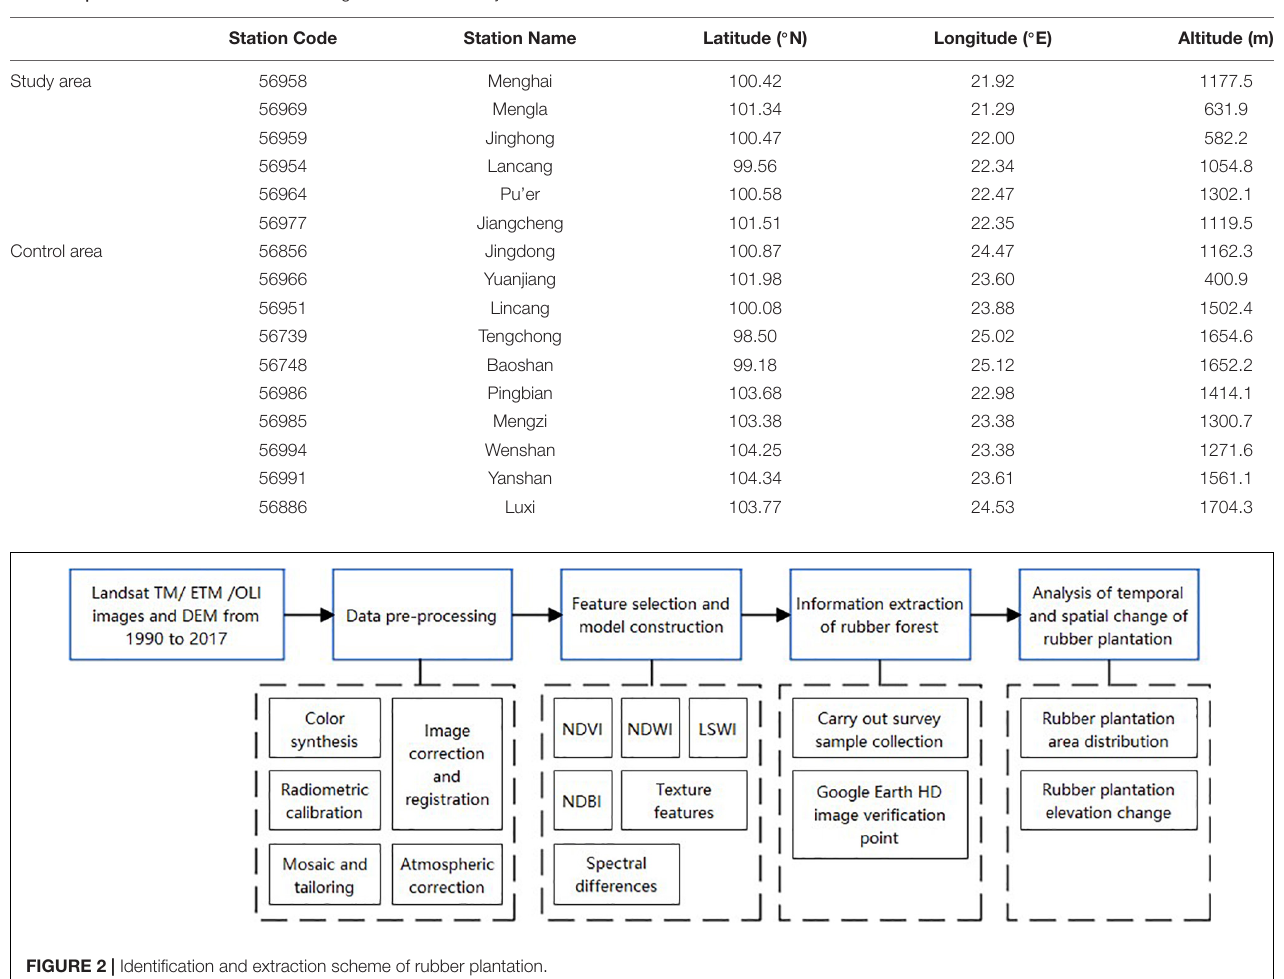
FIGURE 2 | Identification and extraction scheme of rubber